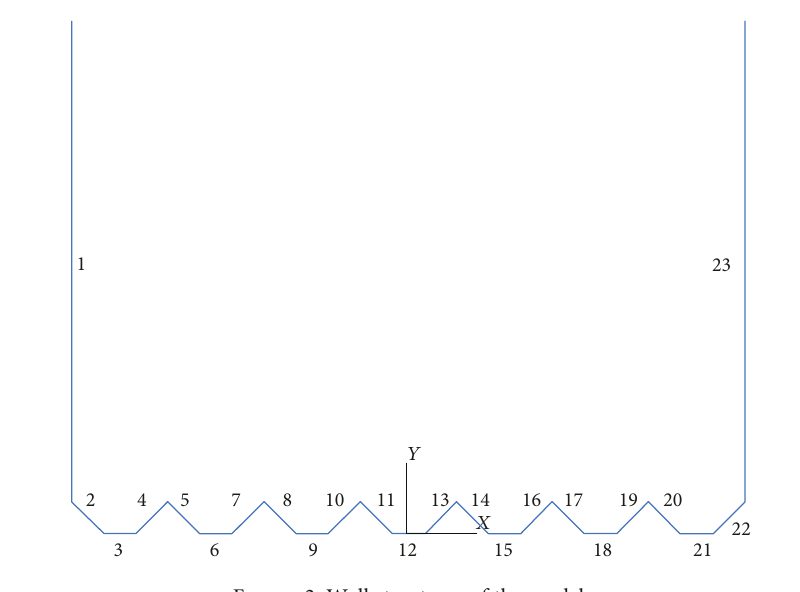
Figure 1: Schematic diagram of the mass draw and synchronous fi lling no-top-pillar shrinkage stoping method: (1) return airway, (2) top pillar, (3) raise, (4) cross-heading, (5) barrier pillar, (6) remaining ore, (7) drift pillar, (8) drawpoint, (9) haulage drive, (10) unmined ore, (11) fi lling material, and (12) barrier.